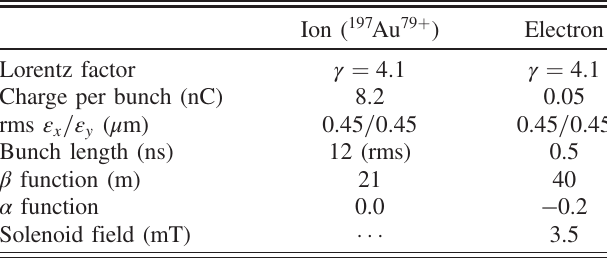
TABLE I. Beam parameters at the start of the